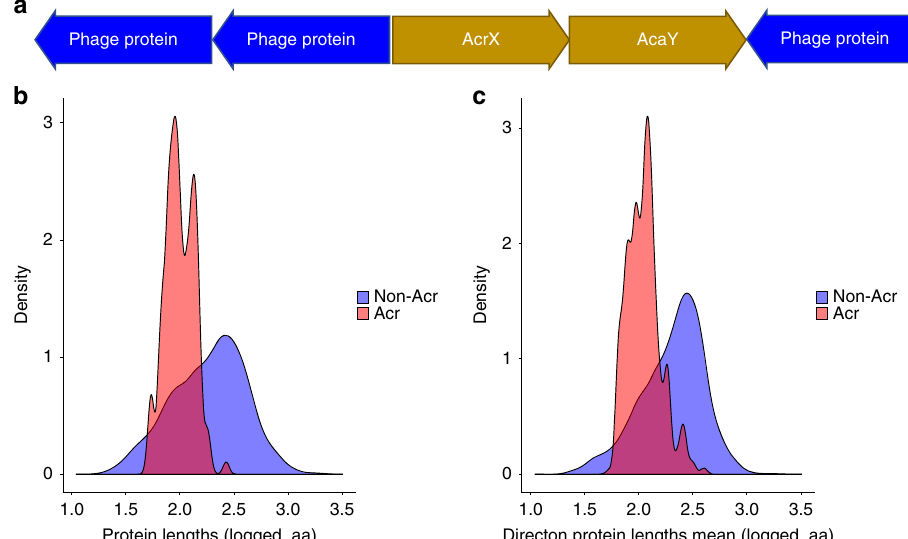
Fig. 1 Characteristics of known Acrs. a A cartoon of a sample directon. Acr proteins characteristically fall upstream of an HTH-domain-containing gene, termed Aca. Acrs are usually found in suspected mobile genetic elements, such as phages. The Acr directon is highlighted in the gold color, while the surrounding proteins are indicated in blue. Characteristically, Acrs fall in directons with small, unidenti fi ed proteins. b A density plot of Acr lengths. The X - axis denotes the common logarithm of the protein length, in amino acids. The Y -axis denotes the probability density function estimated from the data across the values of X . c A density plot of the mean lengths of proteins in Acr directons. The X- axis denotes the common logarithm of the mean length of proteins in an Acr directon, in amino acids. The Y -axis denotes the probability density function estimated from the data across the values of X ( “ Mean Hydrophobicity ” , Table 1). We also considered whether proteins had signi fi cant hits when searched against conserved domains from either the NCBI Conserved Domain Database (CDD) 25 or Prokaryotic Virus Orthologous Groups (pVOG) 26 using PSI-BLAST ( e -value < 10 e − 4, “ Protein is Annotated ” , Table 1), with the expectation that proteins with conserved domains likely perform other functions and therefore are unlikely to be Acrs. In total, we constructed a set of 12 features (Table 1, see “ Methods ” section for details) that, together, provided a compendium of quanti fi able features that were used to identify Acr candidates.